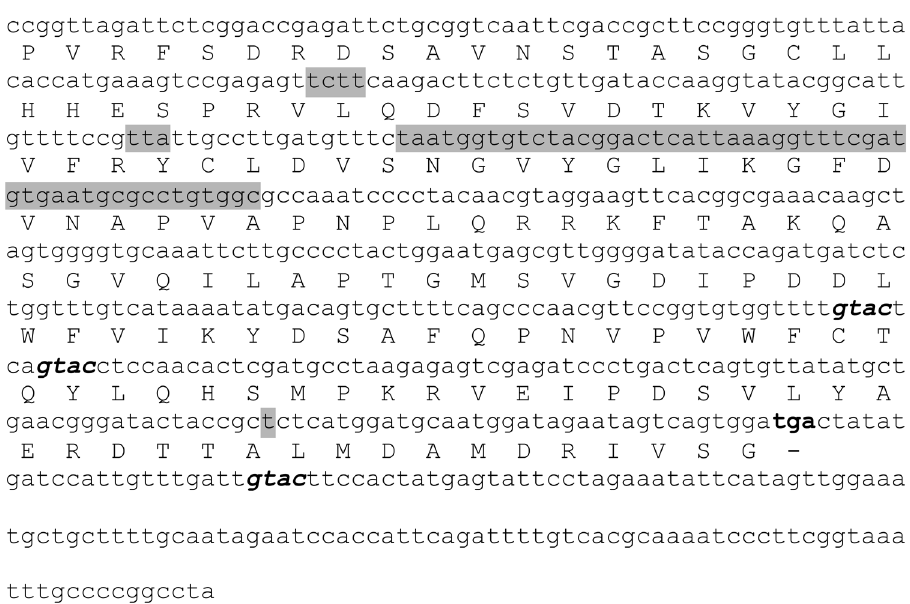
Figure 2. Nucleotide and deduced amino acid sequences of the 613 bp fragment of PDV isolate Jemmal1. The Rsa I restriction sites are indicated in bold and italics. The stop codon is in bold. The recombination sites are shaded.